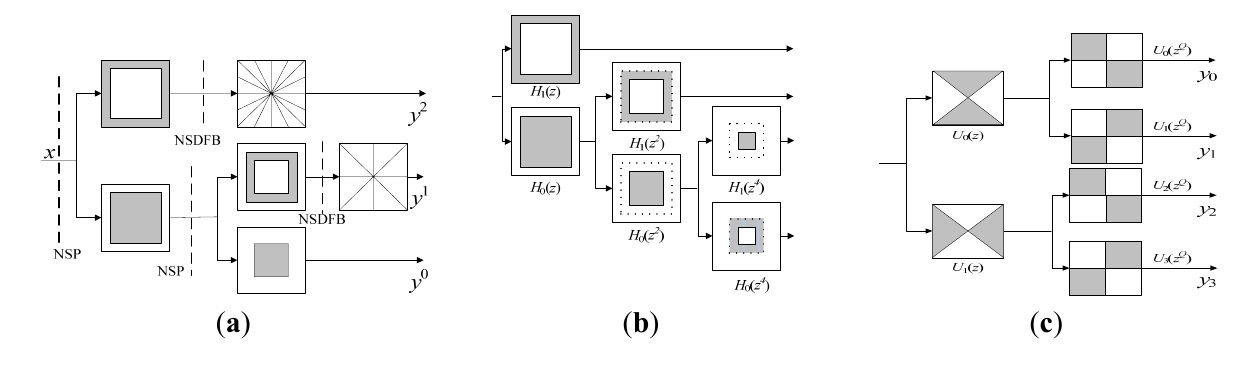
Figure 1. Diagram of NSCT, NSP and NSDFB. ( a ) NSCT filter bands; ( b ) Three-levels NSP; ( c ) Decomposition of